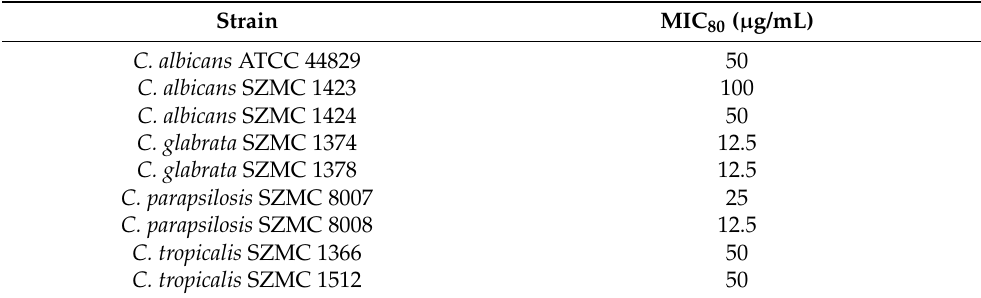
Table 1. MIC 80 values of CAPE against the different Candida strains.